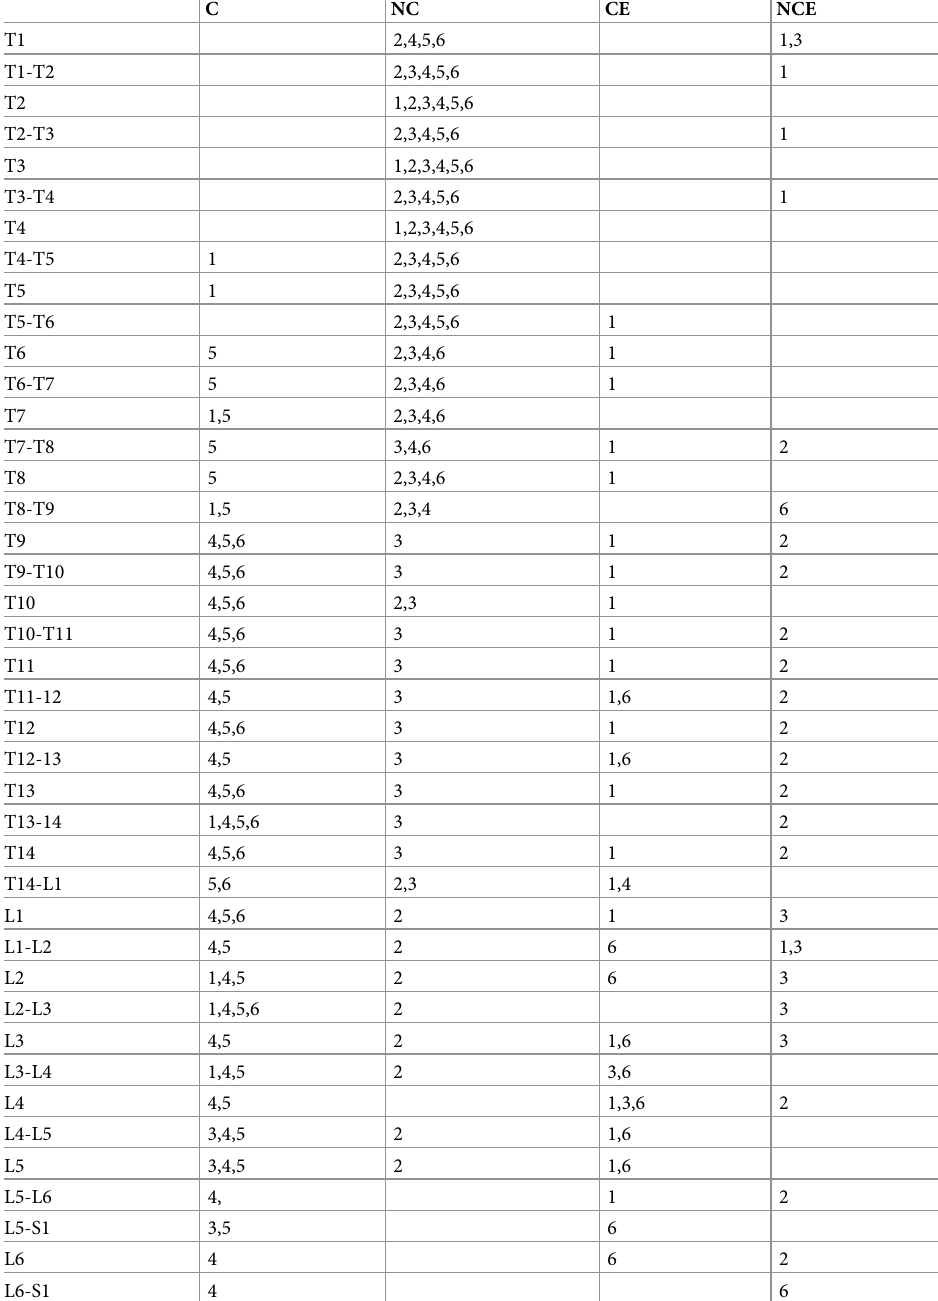
Table 1. Qualitative assessment of contrast filling of the subarachnoid space for each measurement at the mid ver- tebral body and intervertebral disc space (hyphenated). The designation of each sow, 1–6, is listed as numbers in each column for each segment.